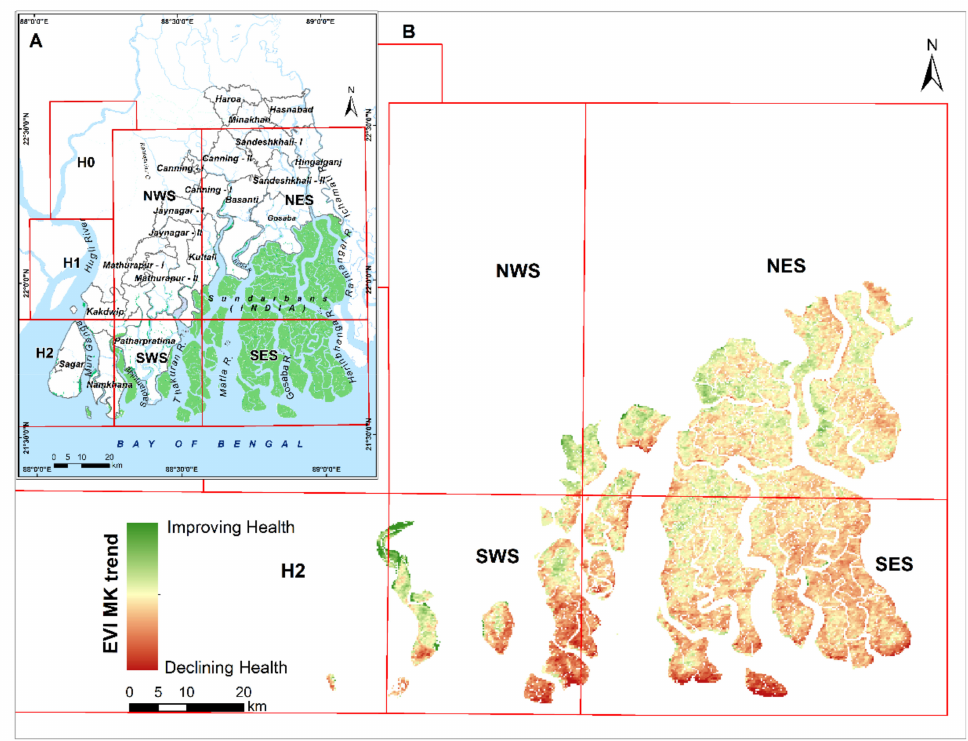
Figure 5. Comparison between salinity zones and mangrove health (MODIS EVI MK test). ( A ) the inset map showing the different salinity zones in SBR and ( B ) the spatial variability of EVI MK.